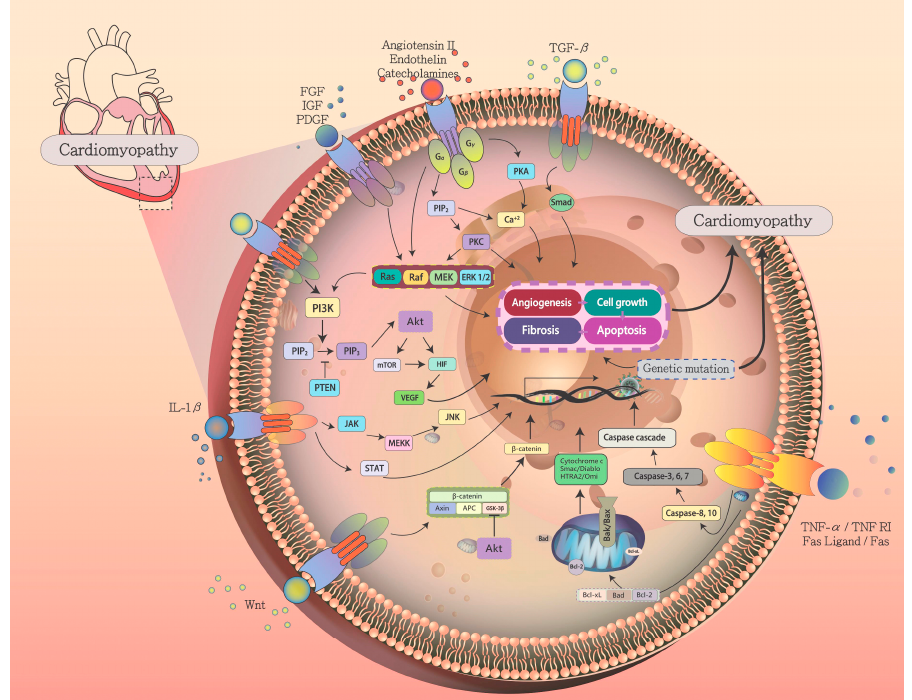
Figure 2. Schematic drawing of the details of the signaling pathways of five major cardiomyopathies. Several pathways, including genetic mutation, Ras/Raf/MEK/ERK signaling pathway, G-protein signaling, Wnt/ β -catenin signaling pathway, AKT/PI3K Pathway, TGF- β signaling, JNK/p38 pathway, and apoptosis pathway, are involved in cardiomyopathy to promote angiogenesis, cell growth, apoptosis and fibrosis, leading to ventricular dilation, hypertrophy, or restriction. FGF: Fibroblast growth factor; IGF: Insulin like growth factor; PDGF: Platelet derived growth factor; TGF: transforming growth factor; PKA: Protein kinase A; PIP2: Phosphatidylinositol 4,5-bisphosphate; PKC: Protein kinase C; MEK: Mitogen-activated protein kinase kinase; ERK: Extracellular-signal- regulated kinase; AKT: Protein kinase B; IL: Interleukin; PTEN: Phosphatase and tensin homolog, PI3K: Phosphoinositide 3-kinases; JAK: Janus kinase; MEKK: Mitogen-activated protein kinase kinase kinase; JNK: c-Jun N-terminal kinase; STAT: Signal transducer and activator of transcription; APC, TNF: Tumor necrosis factor receptor type 1; Fas: Fas cell surface death receptor. 12. Conclusions Cardiomyopathy is a complex disease that is triggered by several risk factors, including genetic mutation, neuromuscular disease, infection, drugs, and toxicity. There are four major types of cardiomyopathies. Several pathways are activated by biomechanical stress. Other growth factors, such as the Ras/Raf/MEK/ERK signaling pathway, G-protein signaling, Wnt/ β -catenin signaling pathway, AKT/PI3K pathway, TGF- β signaling, JNK/MAPK pathway, and the apoptosis pathway, have been implicated in cardiomyopathy. These pathways promote angiogenesis, cell growth, apoptosis, and fibrosis, leading to ventricular dilation, hypertrophy, or restriction. In addition, the PI3K/AKT pathway also induces epithelial-mesenchymal transition, directly contributing to the production of collagen and cardiac fibrosis. Author Contributions: Conceptualization, C.-S.C, C.-J.L. Writing-Original Draft Preparation, M.-Y.W. and C.-J.L.; Writing-Review and Editing, W.-T.L.; Visualization, G.-T.Y. and P.-Y.T. Supervision, M.-Y.W. and C.-J.L. Funding: This study was funded by grants from Taipei Tzu Chi Hospital (TCRD-TPE-108-5). Conflicts of Interest: The authors declare no conflict of interest. References